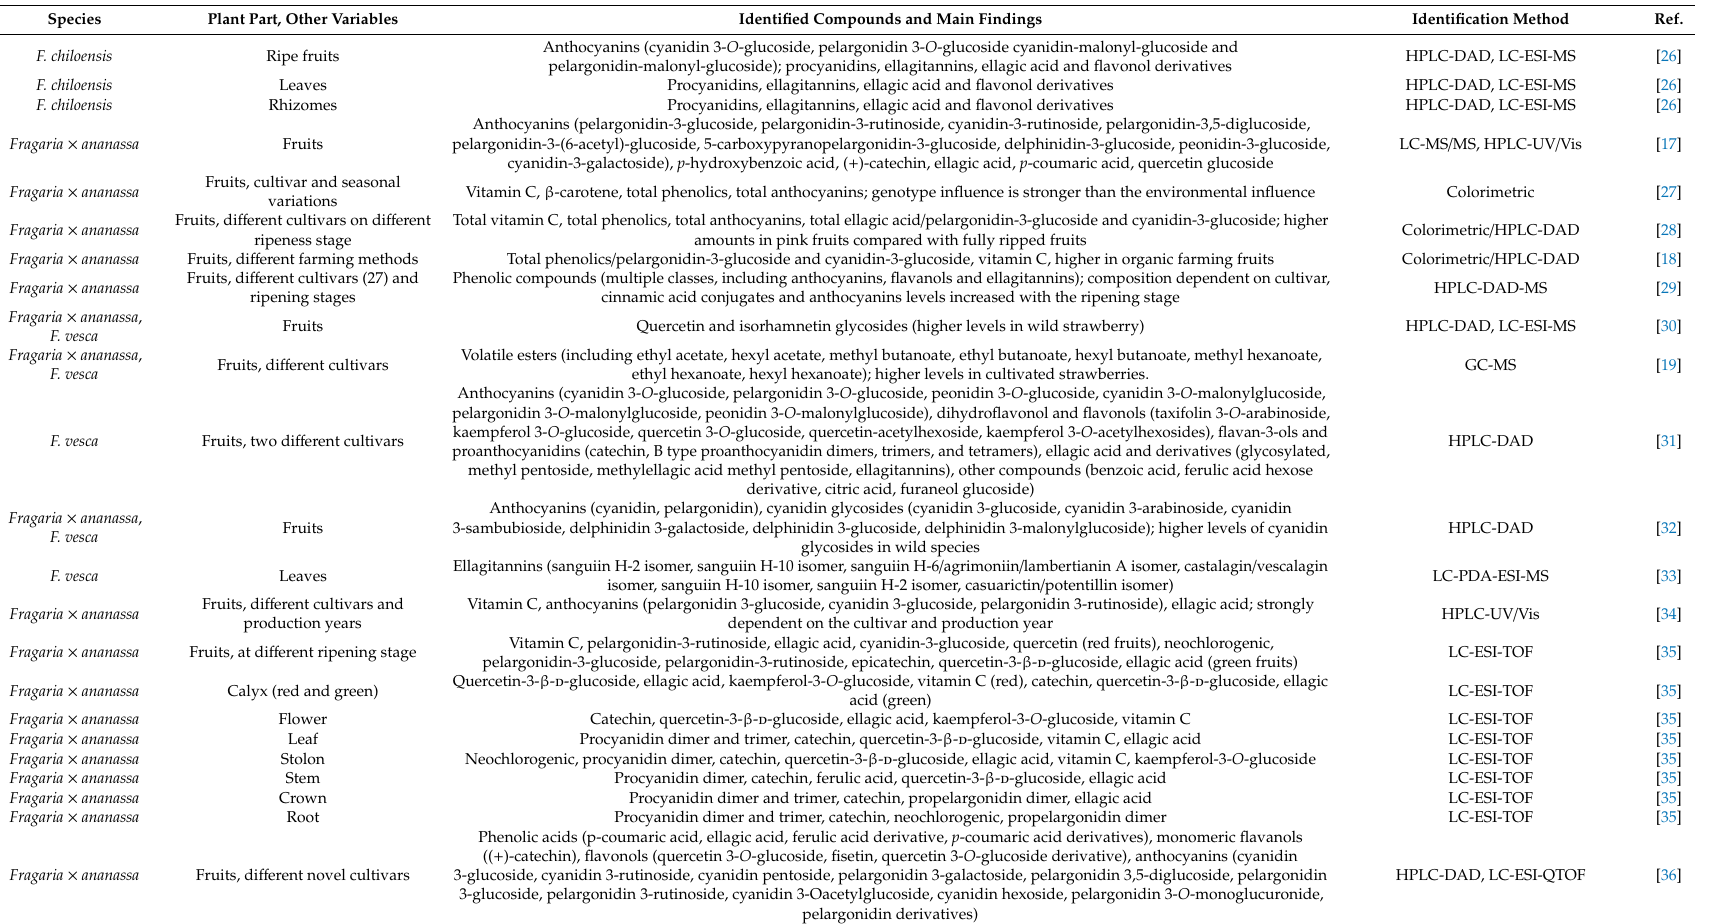
Table 2. Composition of Fragaria species (as presented by original works published in the reviewed period; references presented in chronological order).